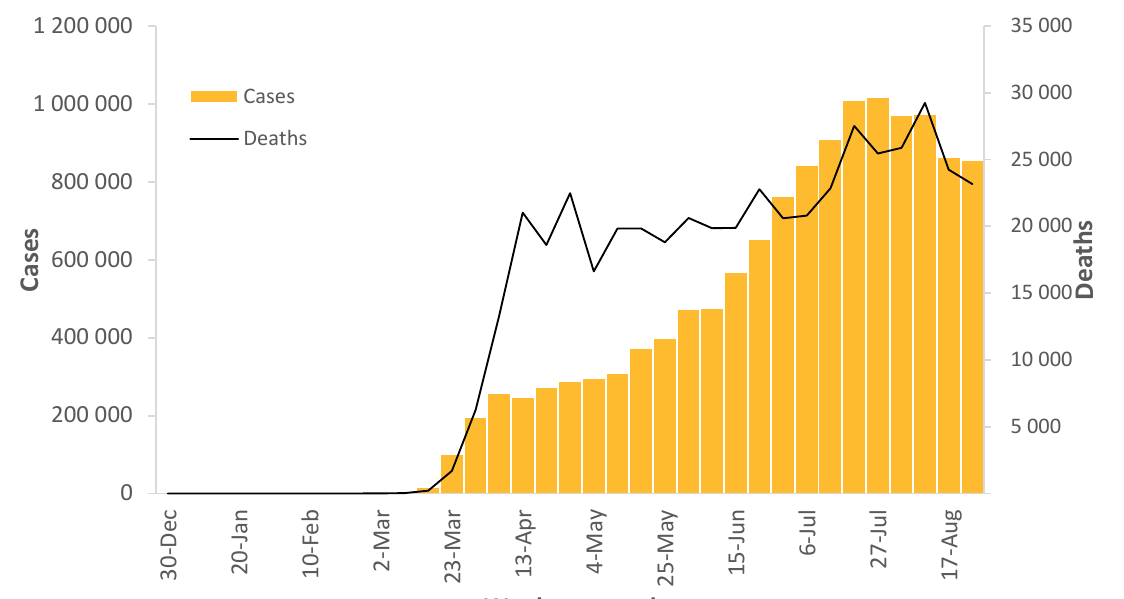
Figure 4: Number of COVID-19 cases and deaths reported weekly by Region of the Americas, data as of